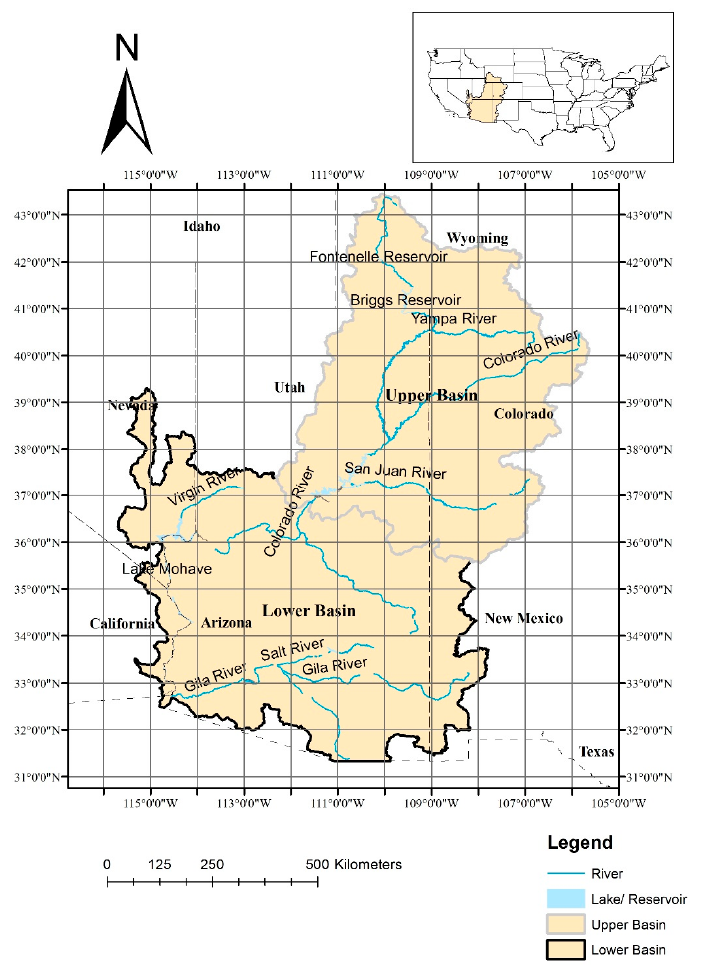
Figure 1. Study area showing the Upper and Lower Colorado River Basin. The grids represent the spatial resolution (1° × 1°) of the utilized GRACE data.